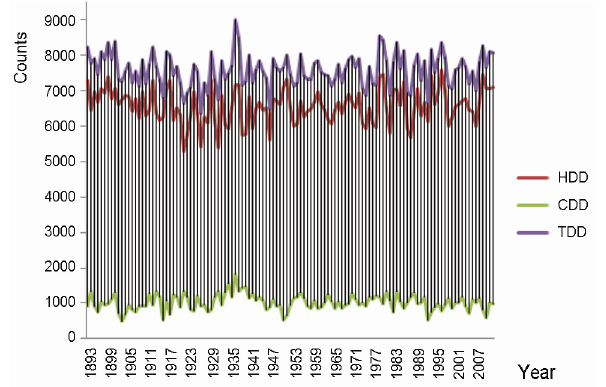
Fig. 11. Annual degree days profile in Woodbine, IA (HDD represents Heating Degree-Day; CDD represents Cooling Degree-Day; TDD represents Total Degree-Day)